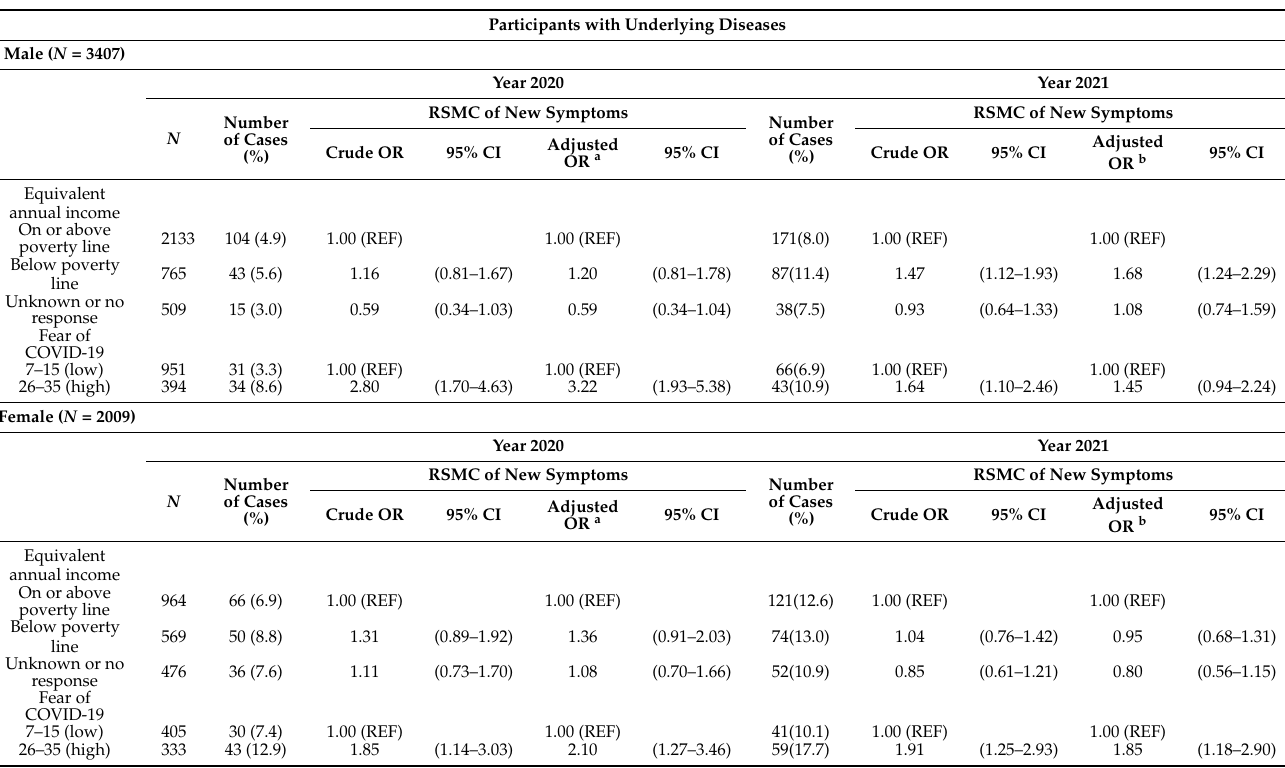
Table A3. Odds ratios (ORs) of household income for refraining from seeking medical care (RSMC) of new symptoms among participants with underlying diseases.